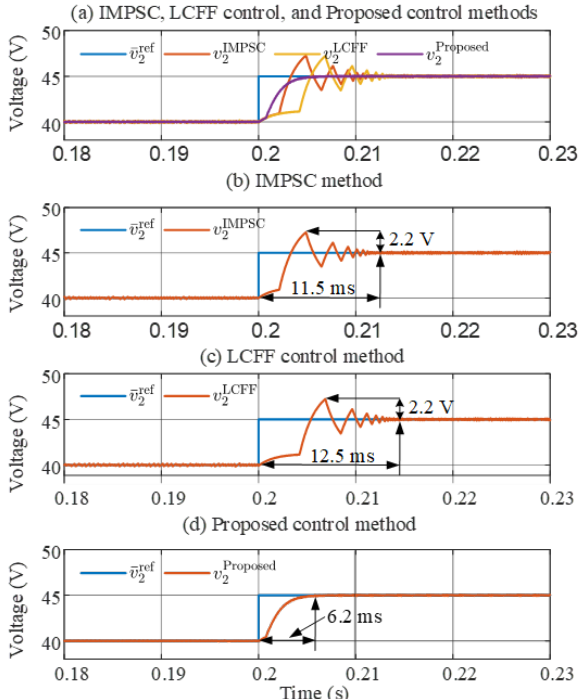
Figure 5. Simulation results of the output voltage when the reference steps up from 40 V to 45 V at t = 0.2 s.